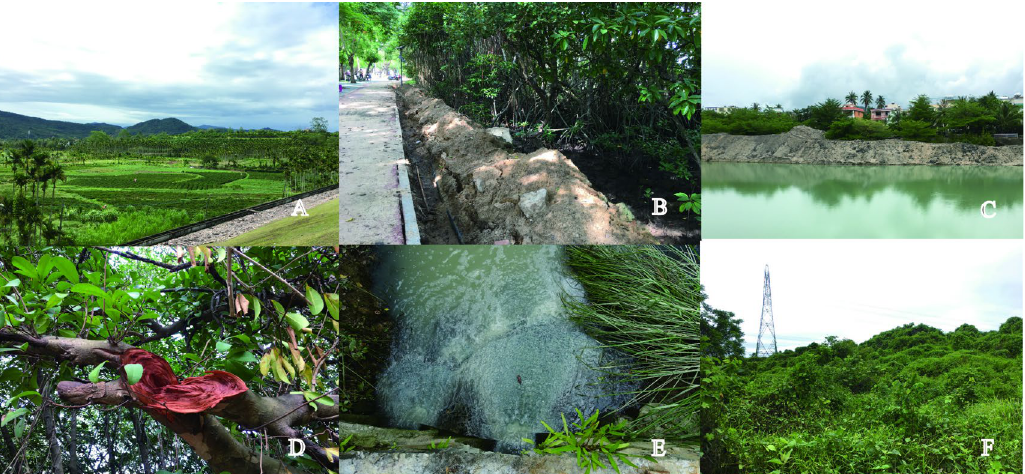
Figure 7. External threat factors to rare and endangered plants in the Sanya River Basin, Hainan Province, China. A : Economic forest and crop planting (Caopeng Reservoir); B : Rainwater and sewage diversion project (Egret Park); C : River dredging project (Areca Cultural Park); D : Broken branches (Egret Park, Xylocarpus granatum ); E : Domestic sewage discharge (Mangrove Ecological Park); F : Covering of exotic invasive species and native woody vines (Banling Reservoir).